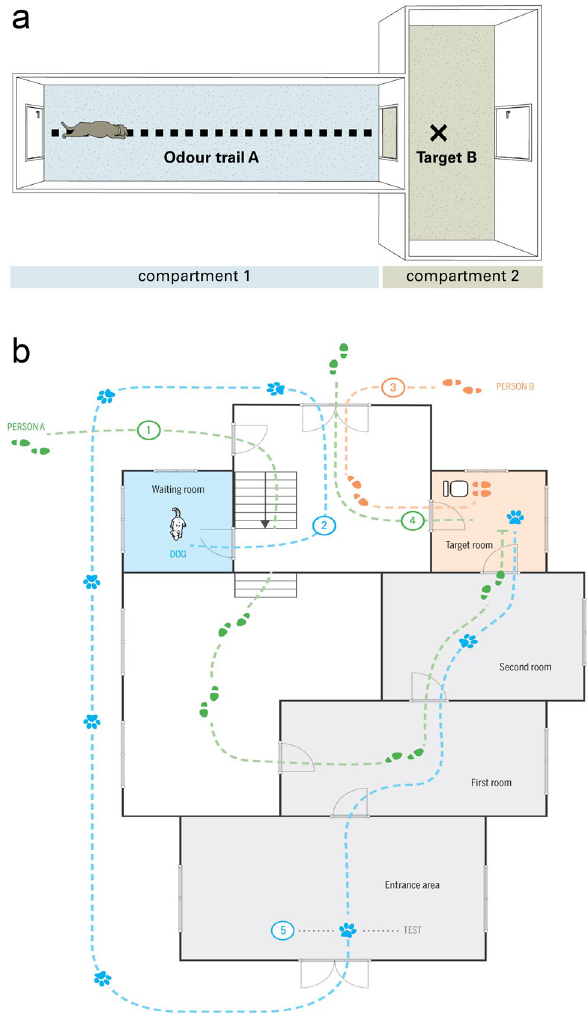
Figure 1. ( a ) General set-up (copyright permission Journal of Comparative Psychology). ( b ) Detailed